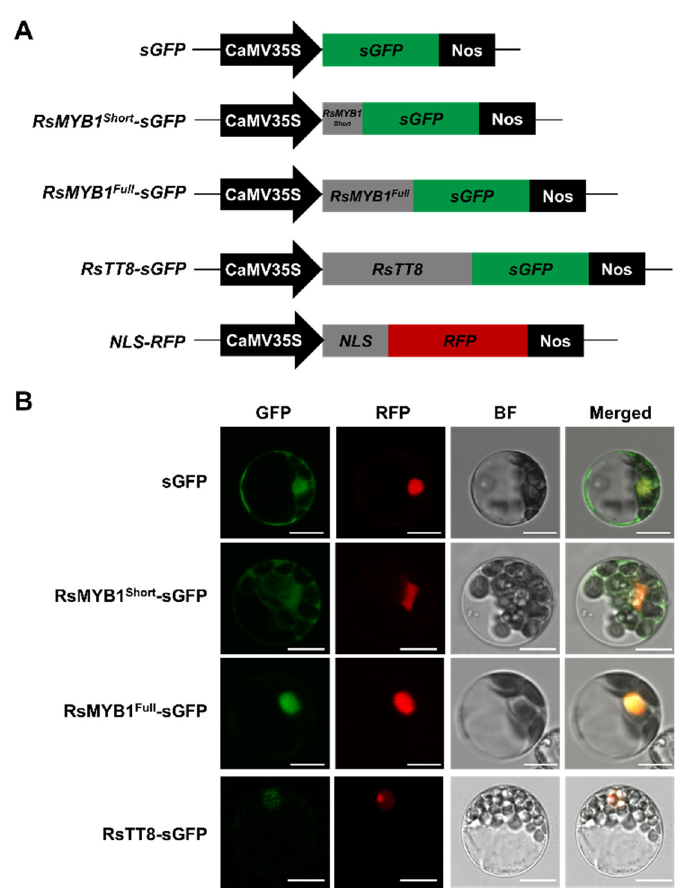
Figure 4. Subcellular localization of RsMYB1 Short , RsMYB1 Full , and RsTT8 in Arabidopsis leaf protoplasts. ( A ) Schematic diagrams of the constructs: CaMV35S, cauliflower mosaic virus 35S promoter; sGFP , soluble green fluorescent protein ( GFP ) gene; RsMYB1 Short -sGFP , RsMYB1 Short fused to sGFP ; RsMYB1 Full -sGFP , RsMYB1 Full fused to sGFP ; RsTT8-sGFP , RsTT8 fused to sGFP ; NLS-RFP , nuclear localization signal fused to the red fluorescent protein ( RFP ) gene; Nos , nopaline synthase terminator. ( B ) RsMYB1 Short , RsMYB1 Full , and RsTT8 localize to the nucleus in Arabidopsis protoplasts. Data are representative of protoplasts accumulating each fusion protein 16 h after transfection. Scale bars = 10 μ m.